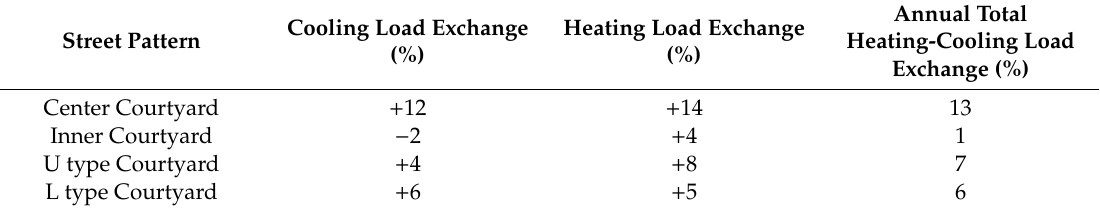
Table 8. Annual energy gain-loss change percentages of building